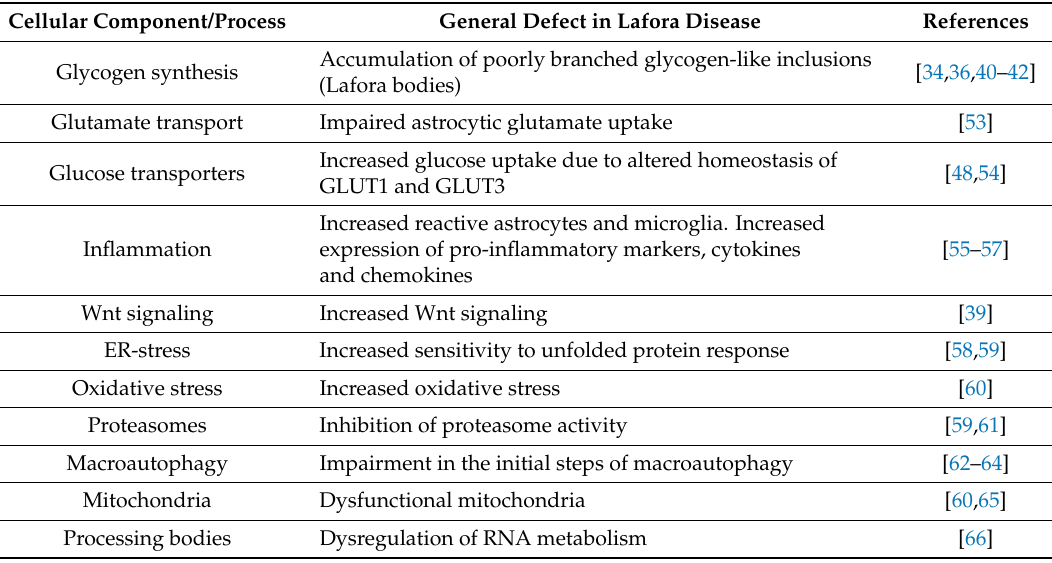
Figure 4. The hallmark of LD is the accumulation of LBs. ( A ) Diagram indicating the possible role of the laforin-malin complex regulating glycogen synthesis; GS: glycogen synthase. ( B ) Samples from the hippocampus of 12 months old control and Epm2b-/- mice (lacking malin) were stained with periodic acid Schiff reagent (PAS staining), which colors polysaccharide granules in red. Table 2. Affected cellular components and processes in Lafora disease.